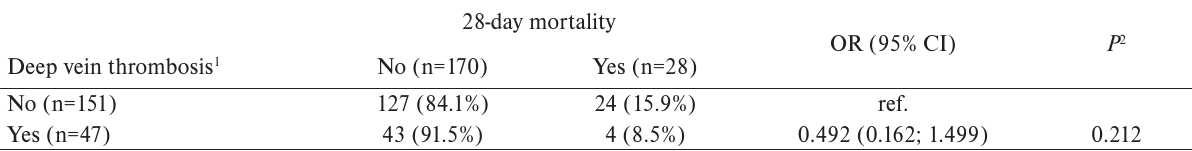
Table 7. Catheter related deep vein thrombosis as a risk factor of 28-day mortality.